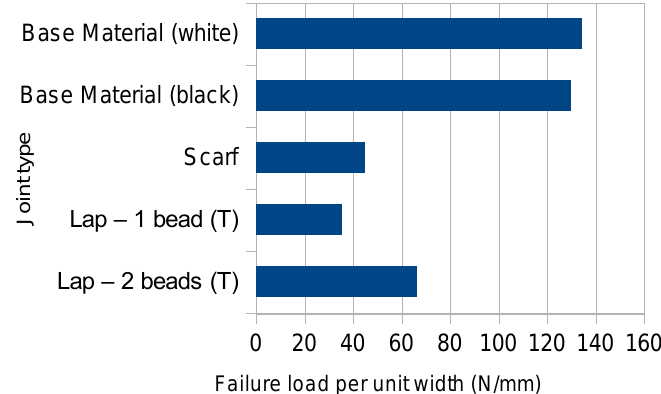
Figure 8. Pictures taken before and after the test of: ( a ) scarf joints; ( b ) single-bead lap joints; ( c ) double-bead lap joints.